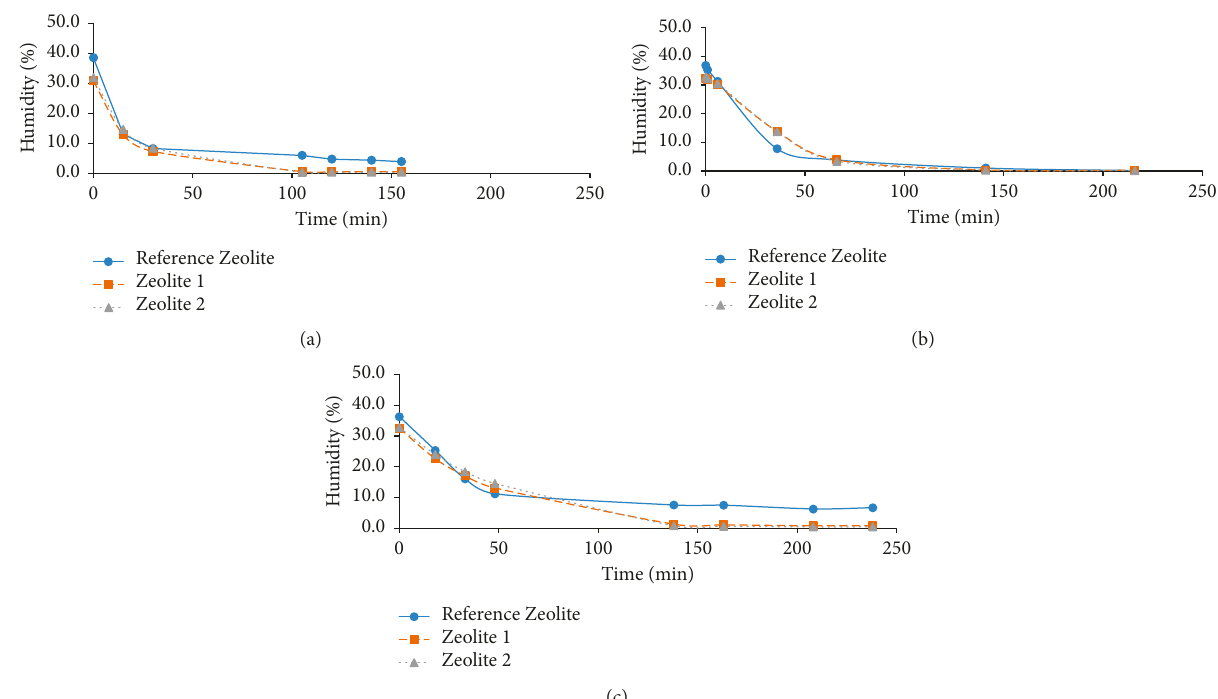
Figure 1: Evolution of water absorption capacity of zeolites.